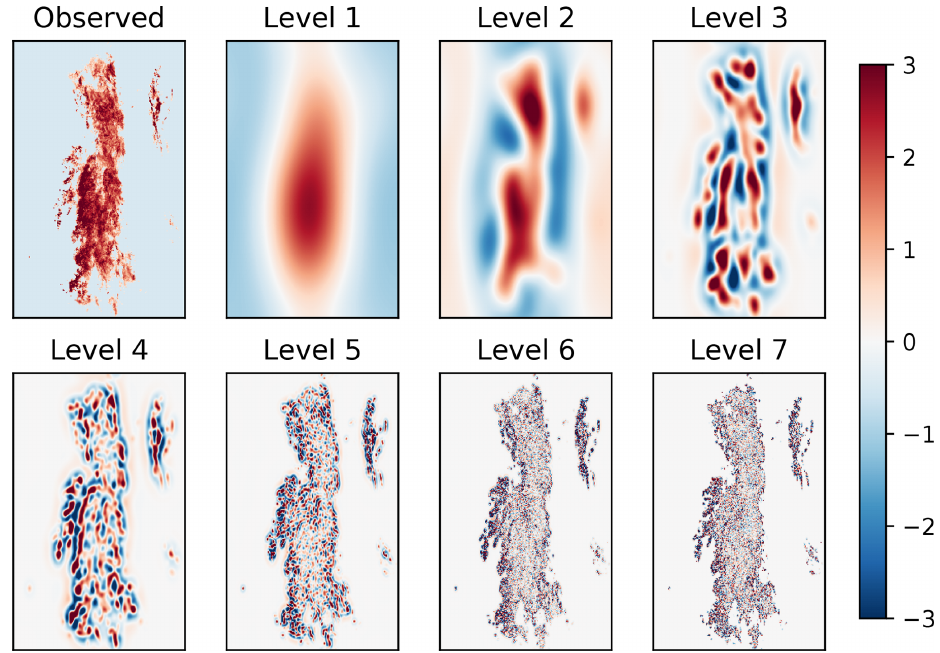
Figure 2. The radar observations and seven first levels of the cascade decomposition of an FMI rain rate composite at 16:00UTC on 28 September 2016. Values below − 10dBR were set to − 15dBR before applying the decomposition in order to reduce the discontinuity at the boundaries of precipitation areas. The observed field and the cascade levels have been normalized to zero mean and unit variance. See Listing A1 in Appendix A for obtaining the